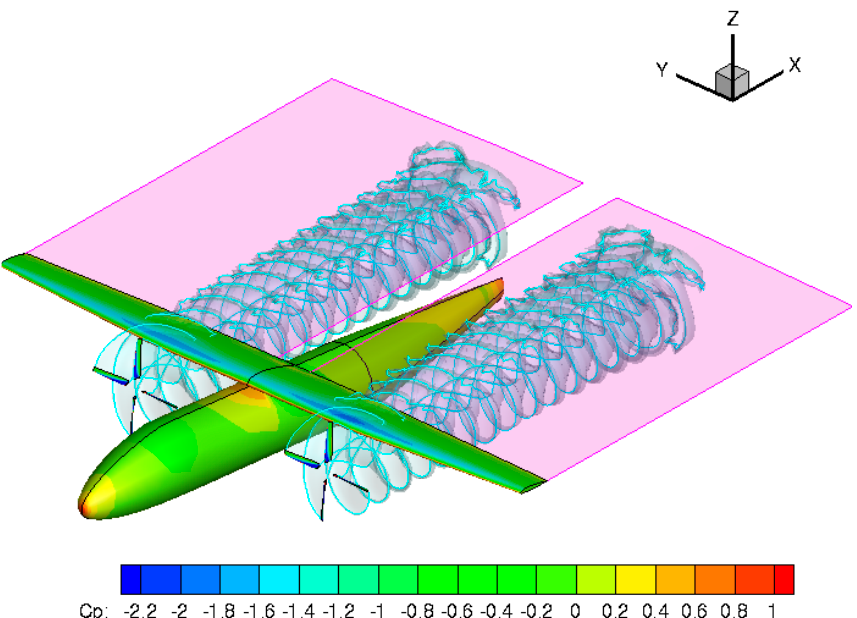
Figure 12. Configuration A—Cp distribution and wake development in a 100%-ETR climb.